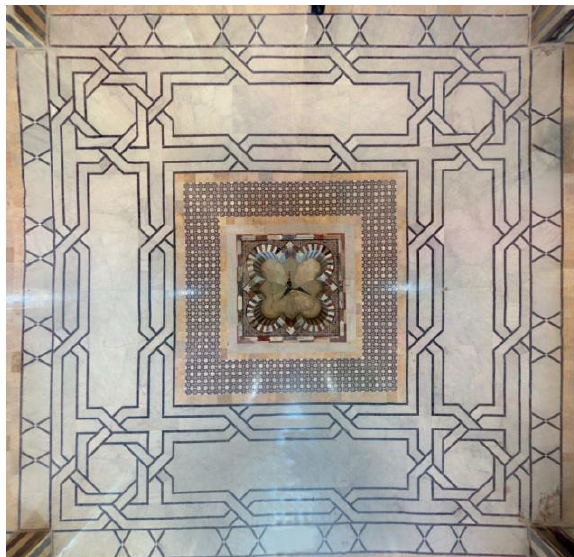
Figure 21. Citadel, the throne hall, the floor